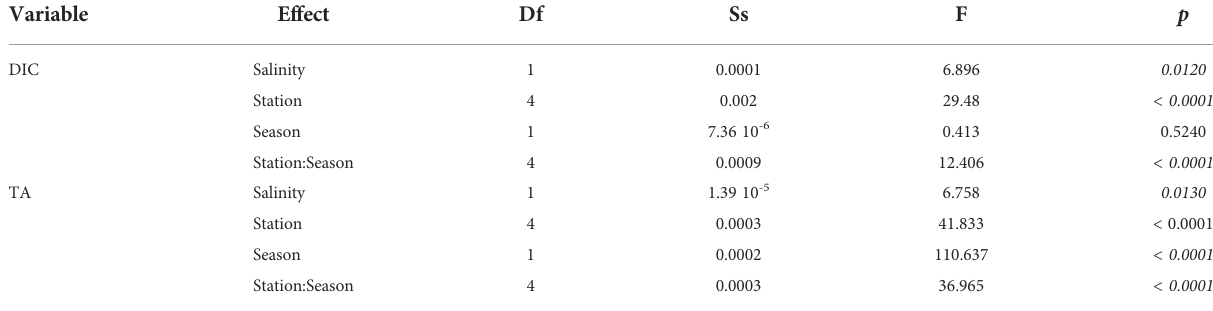
TABLE 1 Summary of analyses (two-way ANCOVA) comparing the effect of station and season to TA and DIC while accounting for salinity.